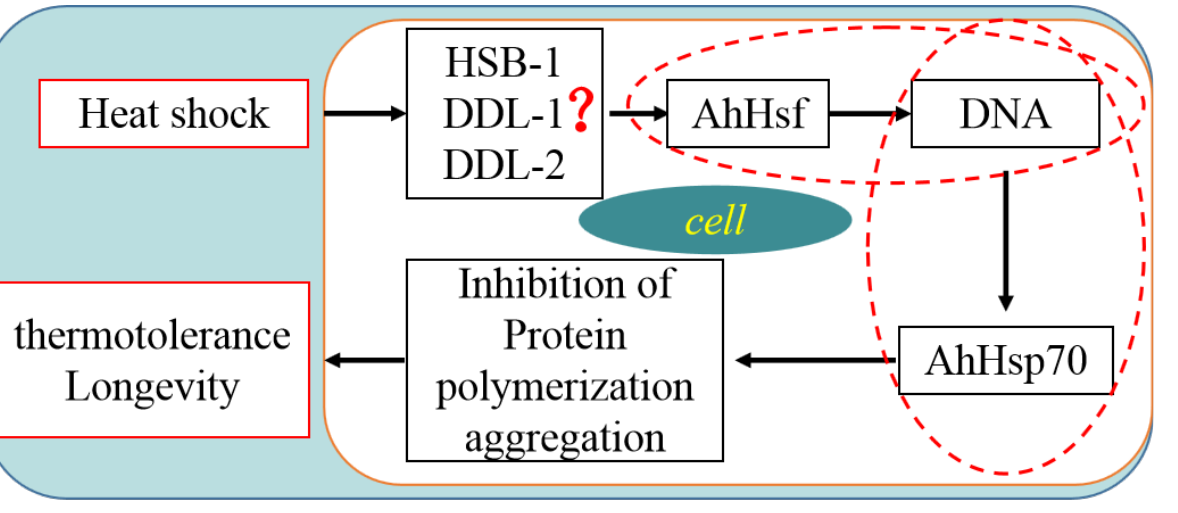
Figure 6. Proposed hypothetical model of the heat shock-induced transcriptional regulation of AhHsp70 gene expression. (HSB-1: Heat shock factor binding protein 1; DDL: WAS protein family homolog).